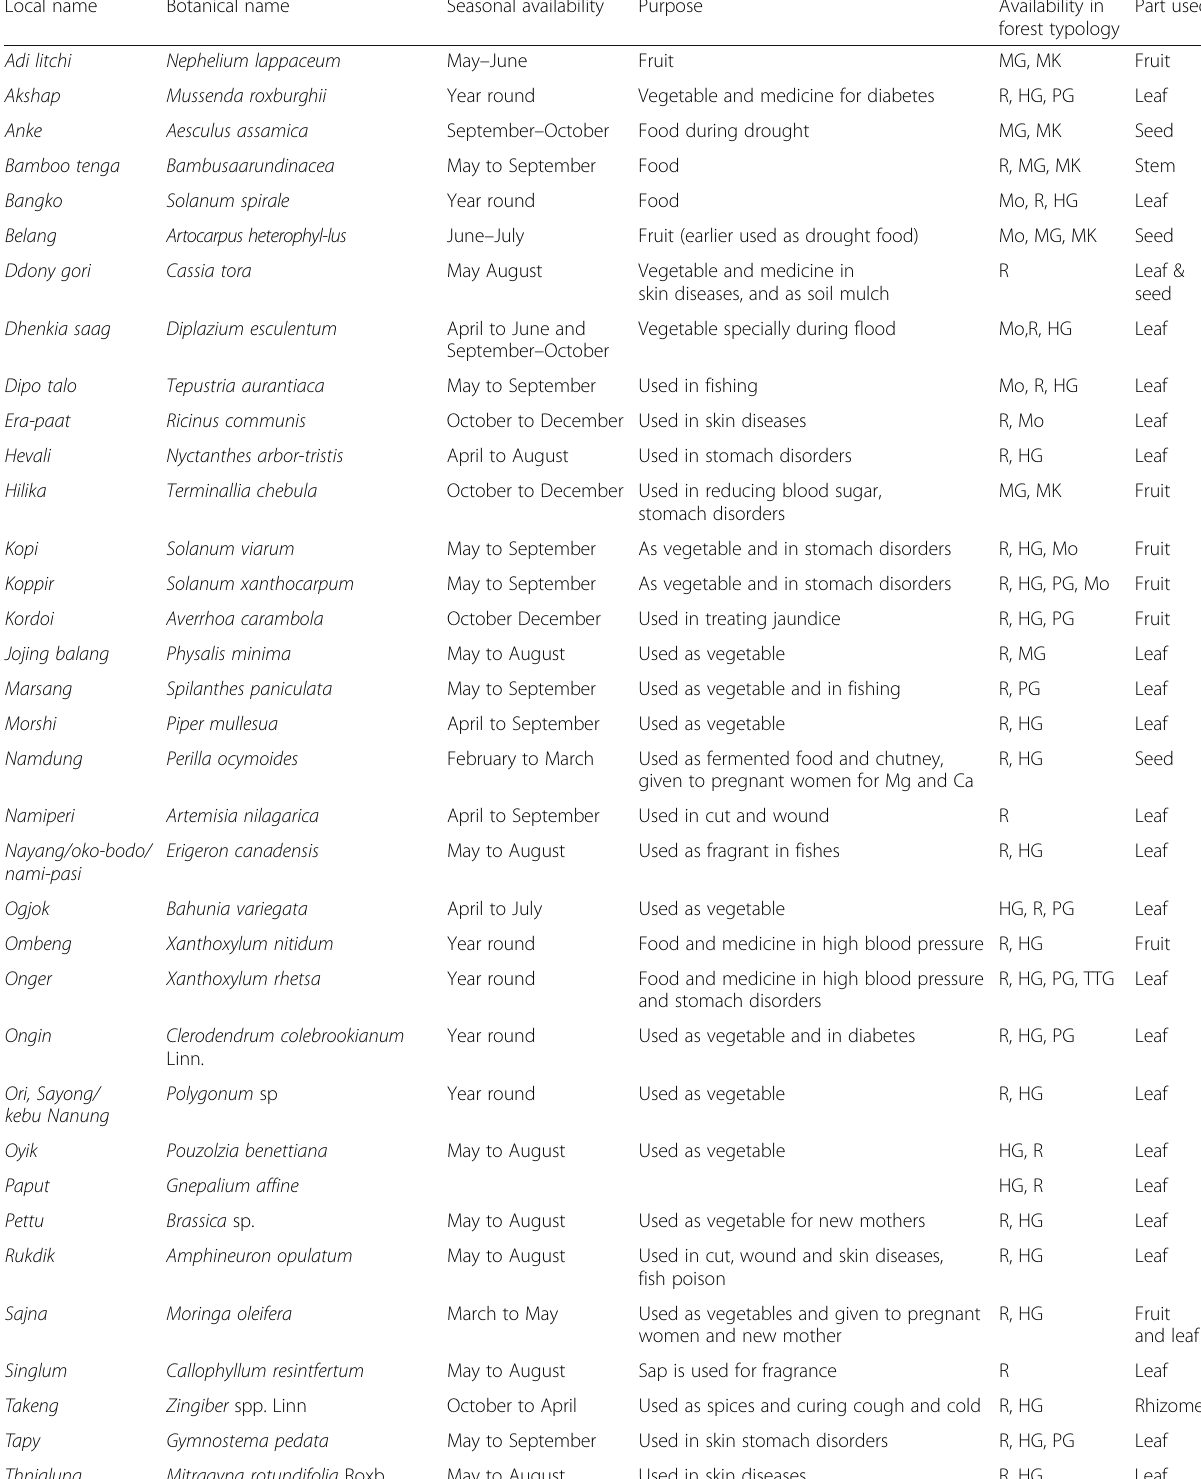
Table 3 Use of major ethnobotanicals by Adi community in remote locations to sustain